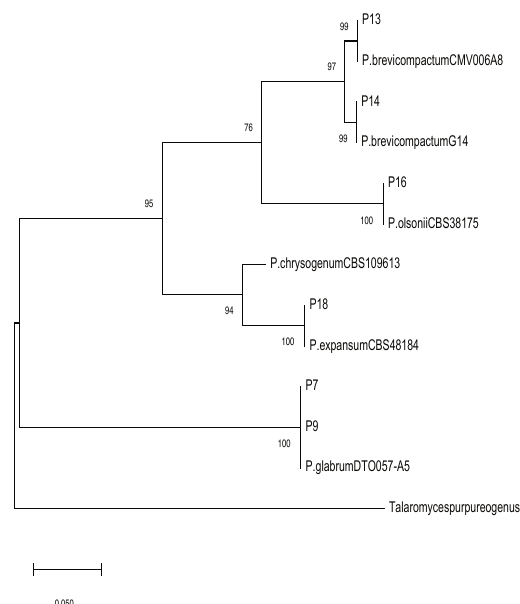
Figure 5. Phylogenetic tree for Penicillium strains based on a por- tion of the β-tubulin gene. Numbers on nodes represent the Maxi- mum Likelihood bootstrap percentages. Branch lengths are propor- tional to the numbers of nucleotide substitutions and can be meas- ured using the bar scale (0.05). Table 6. Alternaria species/species complexes, morphotypes, strains, GenBank accession numbers for the OPA1-3 region, and presence of an alternariol biosynthetic gene ( pksI ). Species Morphotype Strain Accession